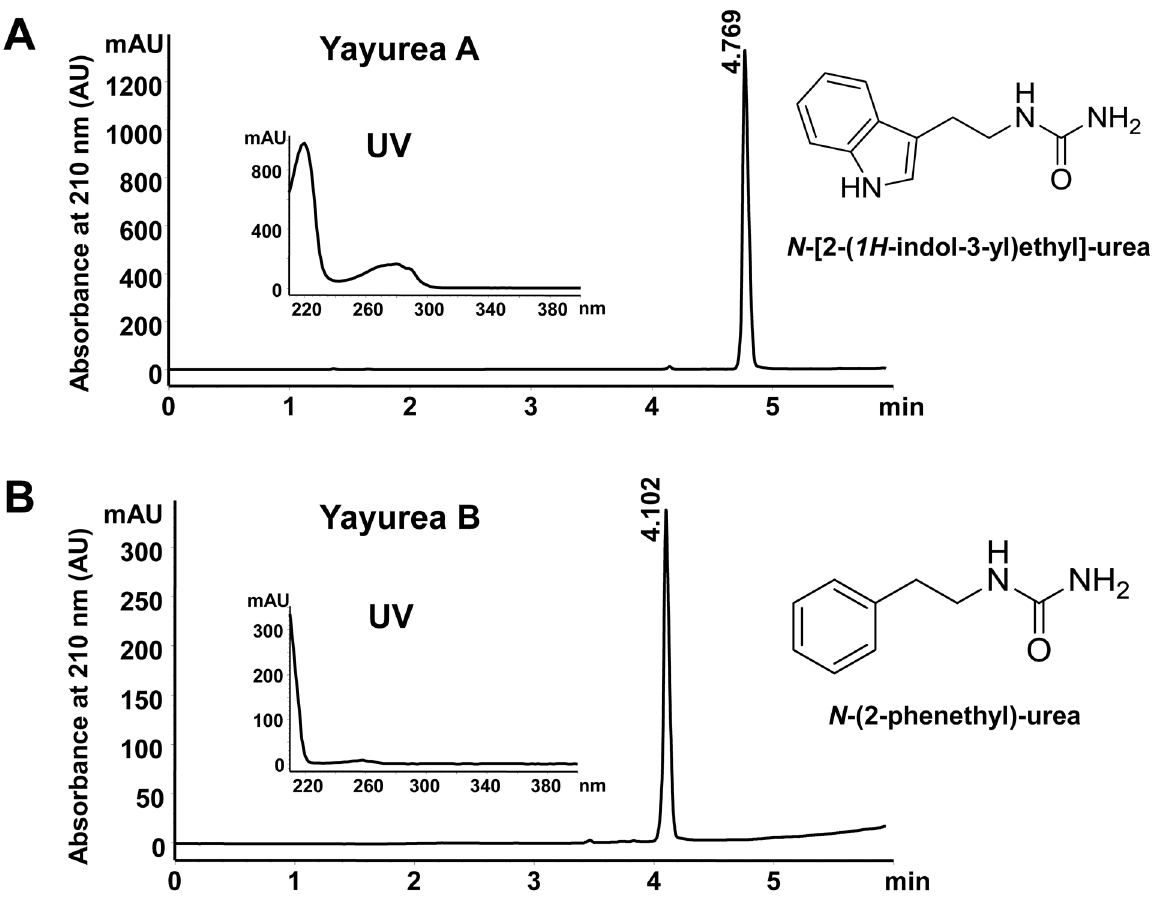
Figure 2. RP-HPLC profile, UV-spectrum and structures of the two QS-inhibitors purified from S.delphini . ( A ) QS-inhibitor, N -[2-(1H- indol-3-yl)ethyl]-urea (yayurea A). ( B ) QS-inhibitor, N -(2-phenethyl)-urea (yayurea B). RP-HPLC was carried out on an Agilent 1200 and Waters xBridge C18, 5 mm, 4.6 6 150 mm column; compounds were eluted with a 15 min linear gradient of 0.1% phosphoric acid to acetonitrile at a flow rate of 1.5 ml/min.